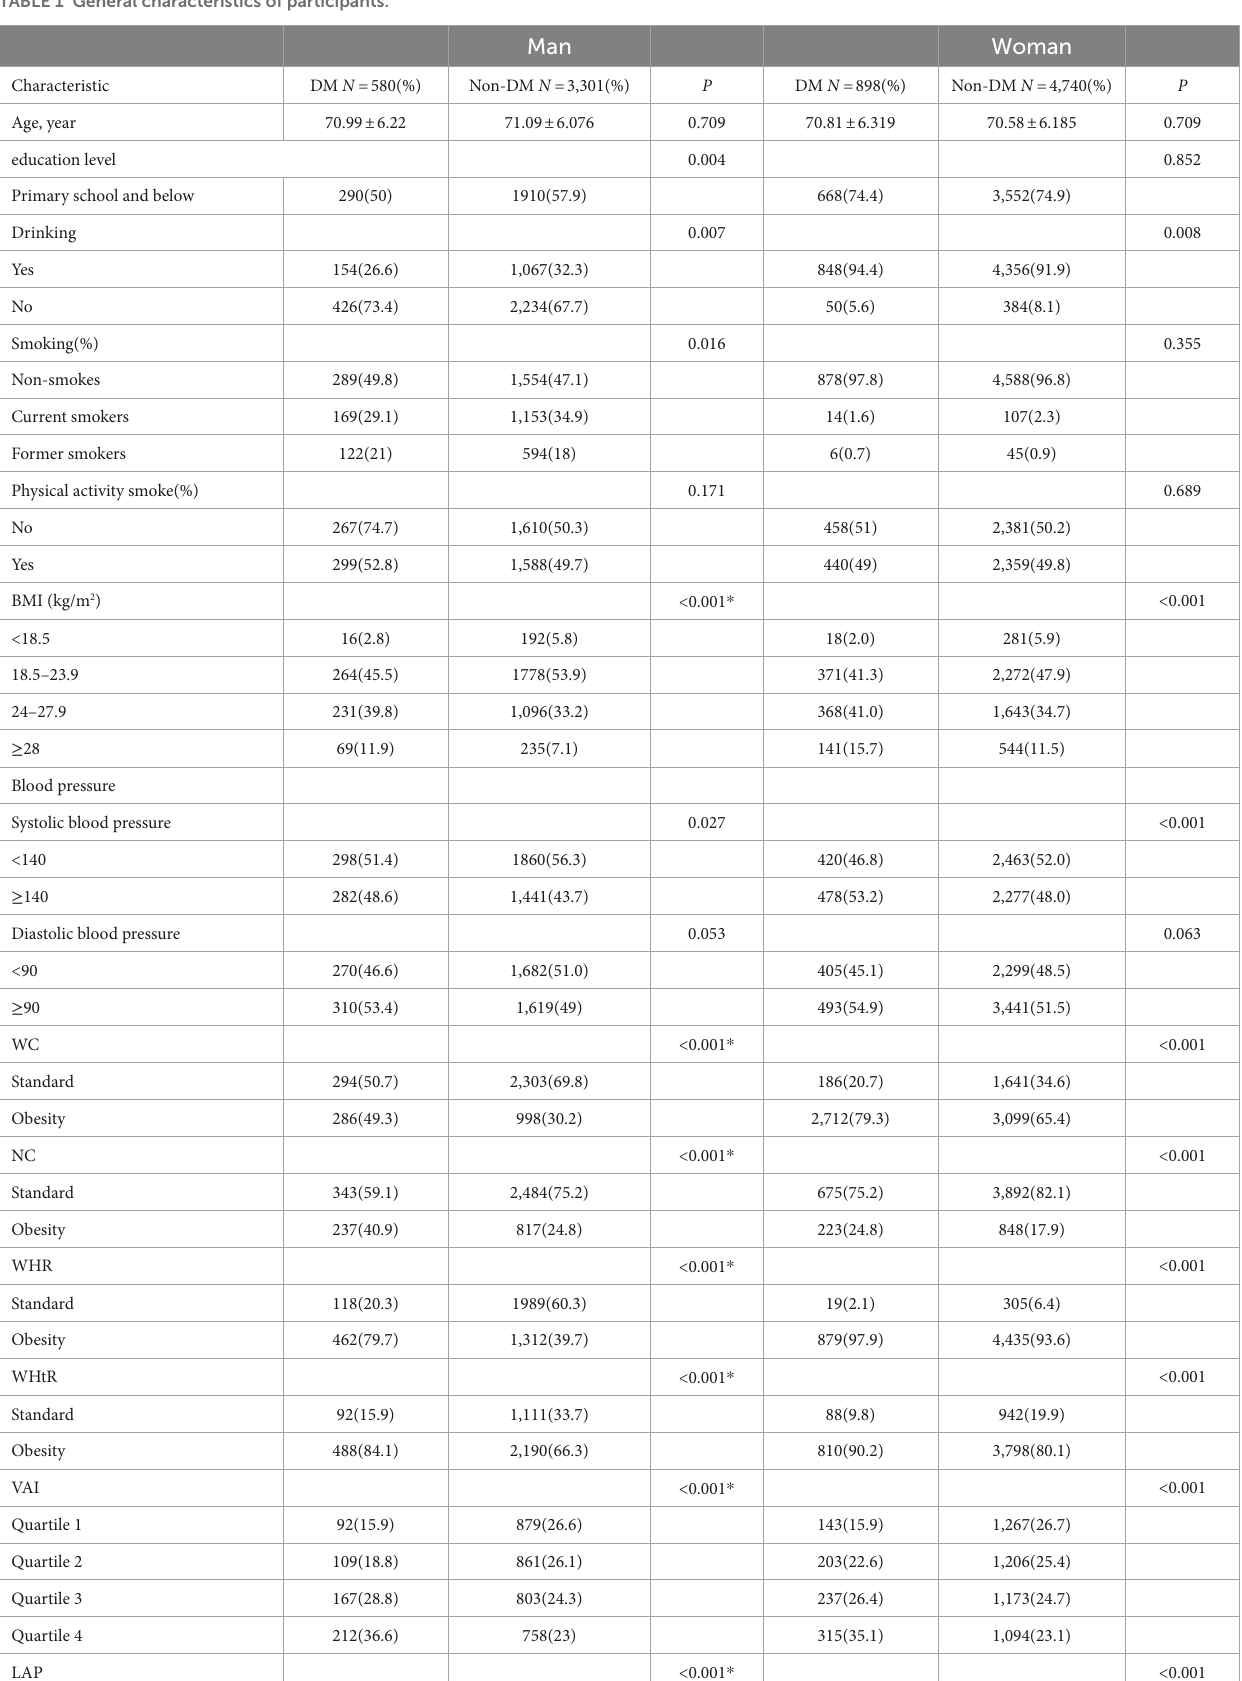
TABLE 1 General characteristics of participants.